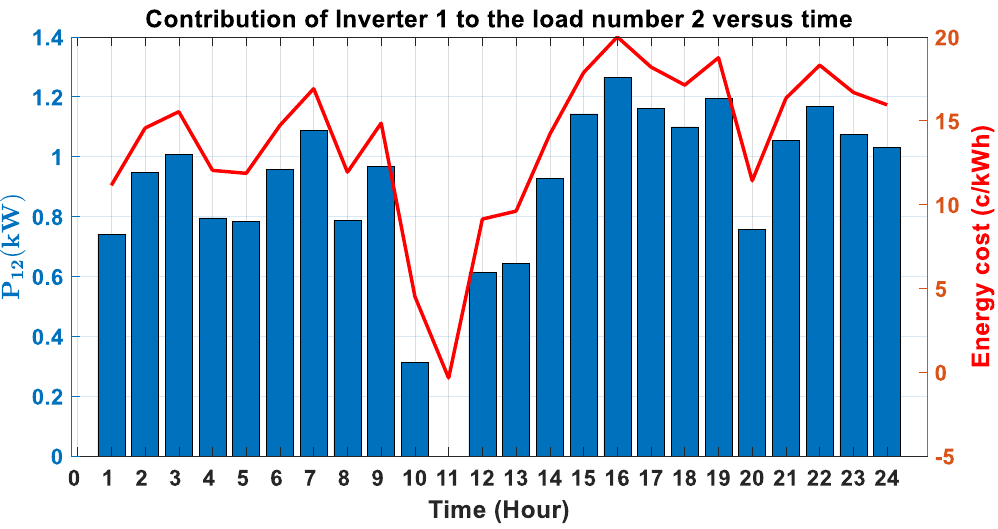
Figure 3. Contribution of inverter 1 to load 2 along with the electricity price. Energies 2020 , 13 , x FOR PEER REVIEW